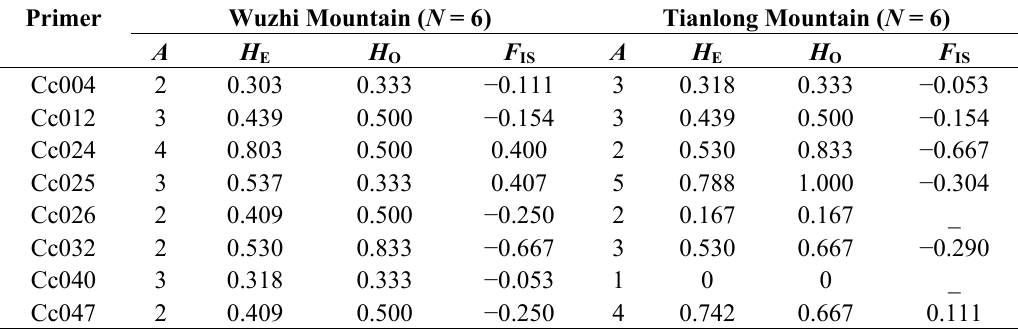
Table 2. Genetic diversity parameters for two populations of Cotinus coggygria